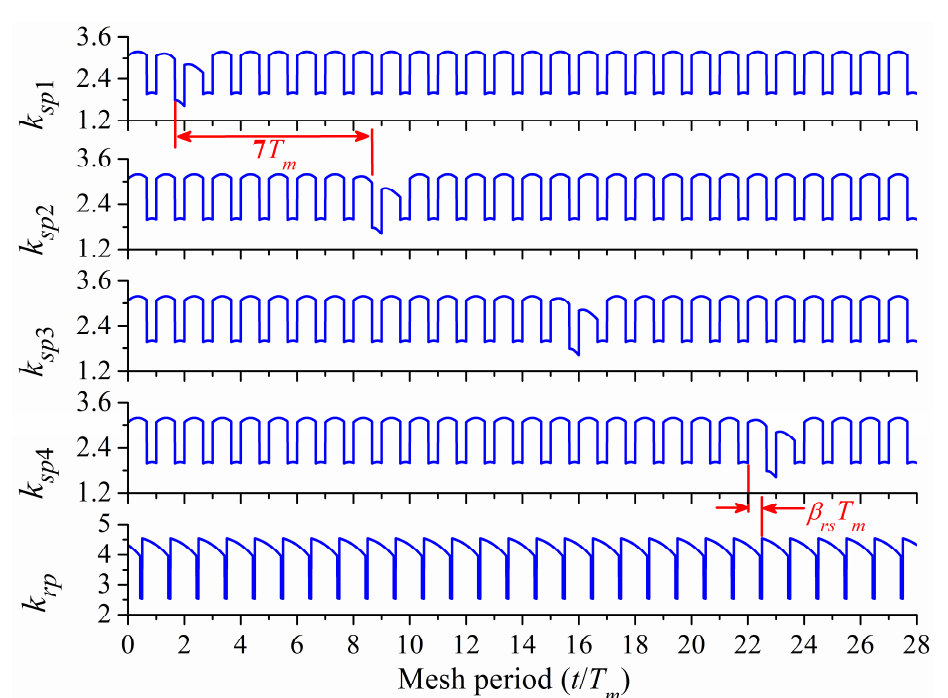
Figure 16. TVMS of the sun–planet pair s and the ring–planet pairs.